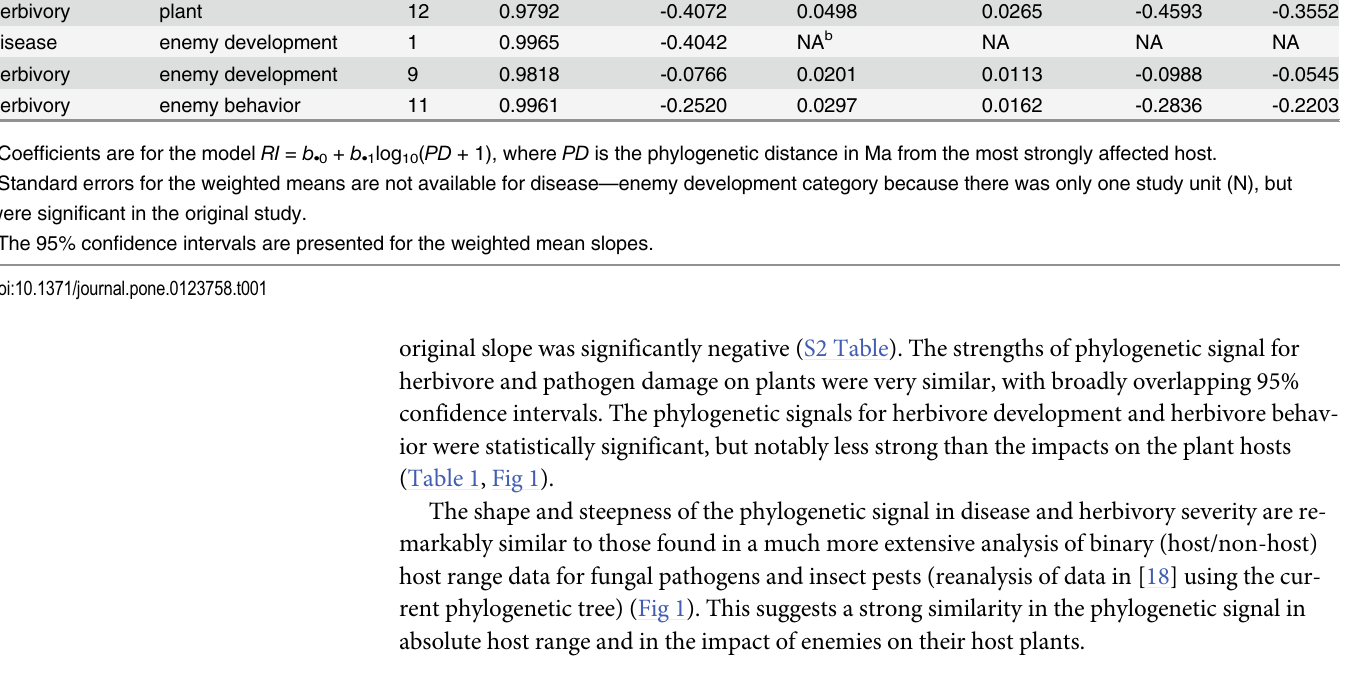
Table 1. Weighted means of intercept ( b (cid:129) 0 ) and slope ( b (cid:129) 1 ) from the study-unit regressions described in S2 Table, for each of five types of interac- tion type and measured impact. Interaction